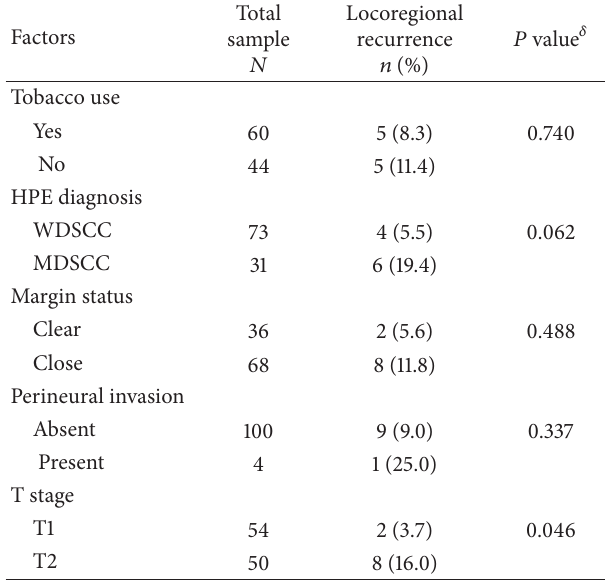
Table 4: Univariate analysis for risk of recurrence in the